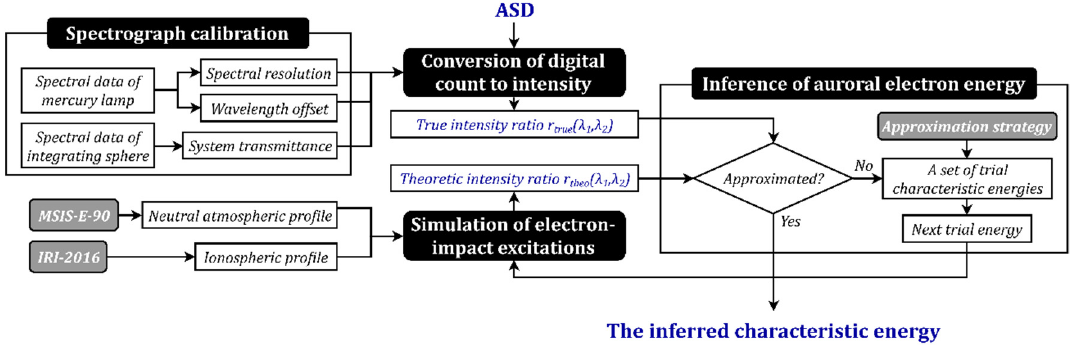
Figure 3. Diagram of the scheme to derive the auroral electron energy.